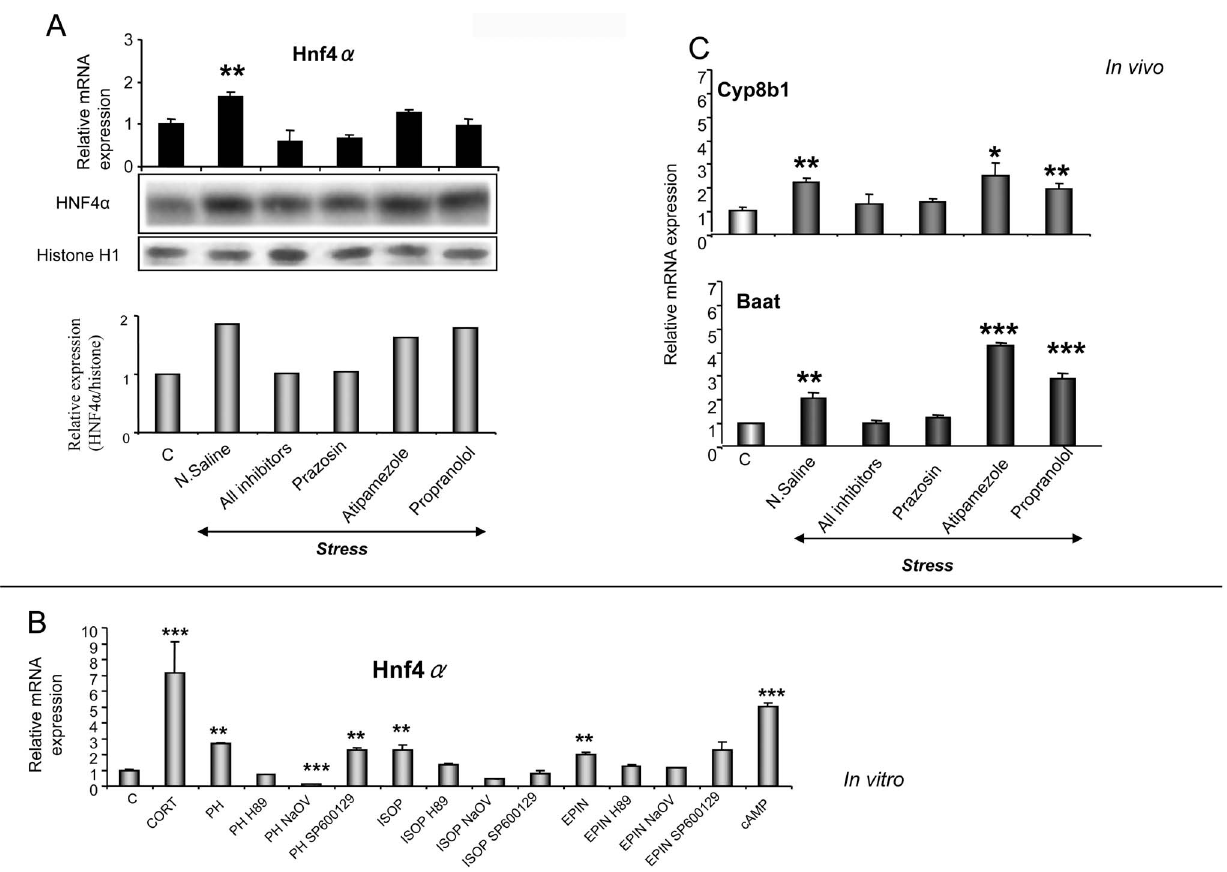
Figure 4. Stress-induced effect on Hnf4a expression. A. Following restraint stress alone or coupled with AR-antagonists hepatic Hnf4a mRNA levels were analysed in wild-type mice by qPCR. HNF4 a protein was measured in liver nuclear fractions by Western blot analysis. Histone H1 served as a loading control. B. Cyp8b1 and Baat mRNA levels were analyzed in the livers of wild-type mice by qPCR following treatment with either restraint stress alone or coupled with AR-antagonists (dark bars). C. Hnf4a mRNA levels were determined by qPCR following treatment of primary hepatocyte cultures with either corticosterone (CORT), epinephrine (EPIN) or AR-agonists for 24 hours. Primary hepatocytes were also treated with AR-agonists in combination with the JNK inhibitor, SP600125 (SP), or the PKA inhibitors, H89 or sodium orthovanadate (NaOV). Values were normalized to b -actin and are expressed as mean 6 SE (n=8–10). Comparisons were between controls and stress- or drug-treated mice. AR: adrenergic receptor, C: control, N. Saline: normal saline, All inhibitors: mice were treated with all AR-antagonists prior to stress, Prazosin (alpha 1 -AR antagonist), Atipamezole (alpha 2 - AR antagonist), Propranolol (beta-AR antagonist), PH: Phenylephrine (alpha 1 -AR agonist), ISOP: Isoprenaline (beta-AR agonist). Group differences were calculated by one-way ANOVA, followed by Bonferonni’s test. *P , 0.025, **P , 0.01, ***P ,